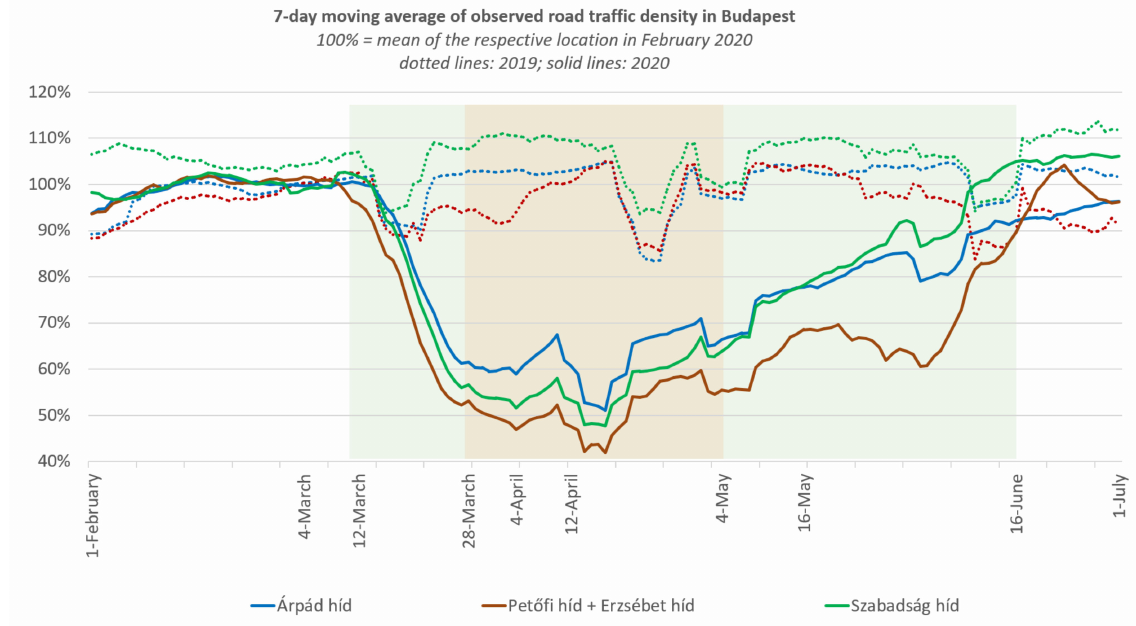
Figure 2. Seven-day moving average of observed road traffic density in Budapest at different cross-sections (dotted lines: 2019, solid lines: 2020). A total of 100% equals the mean traffic density of February 2020 (pre-lockdown) at the respective sites. Study periods are marked with colored boxes (green: “emergency” with partial lockdown; red: “curfew” with general mobility restrictions). Data from Budapest Public Roads Company (Budapest Köz ú t). Table 1. COVID-related traffic reduction at different road cross-sections of